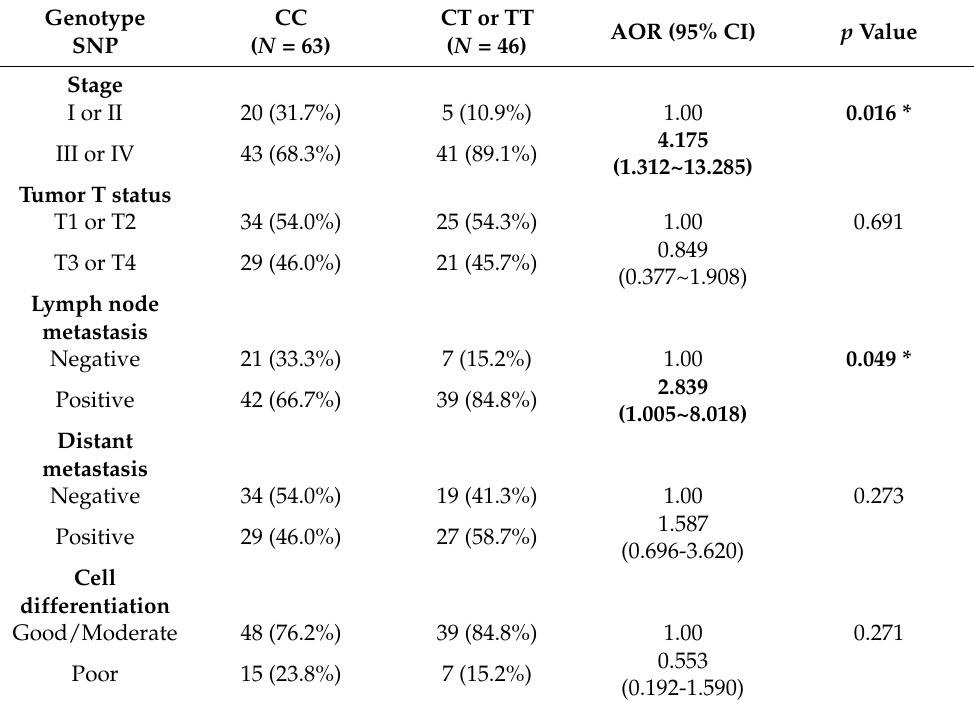
Table 4. Clinicopathologic characteristics of lung adenocarcinoma patients with wild-type epidermal growth factor receptor (EGFR), stratified by polymorphic genotypes of interleukin ( IL )- 17A